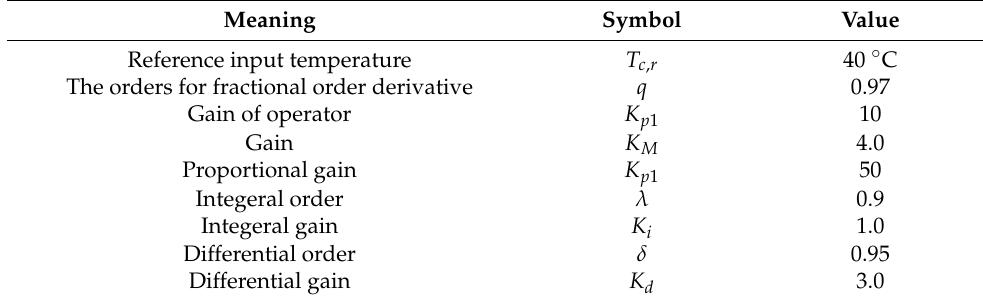
Table 4. Tuning parameters for FOPID Controller with operator controller.